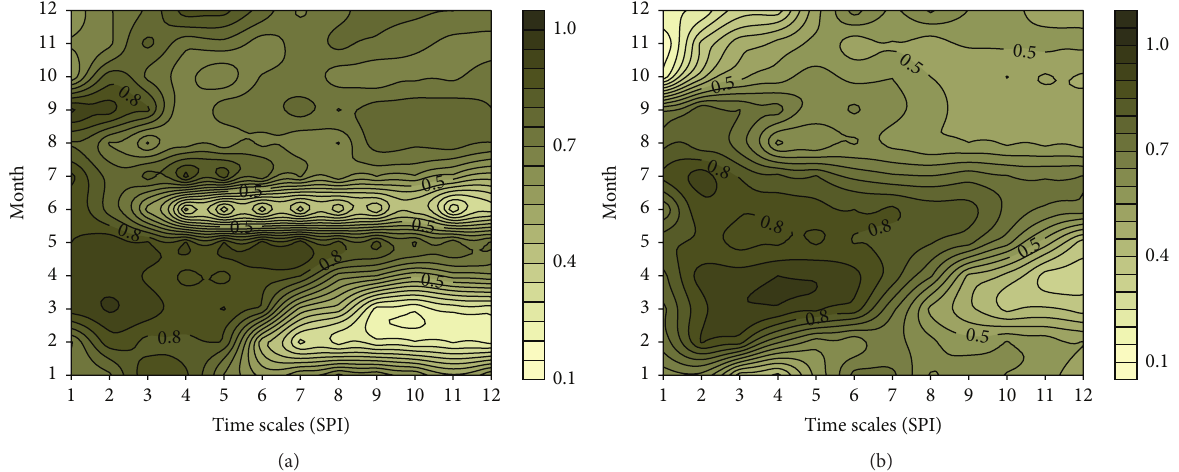
Figure 5: Monthly correlation coefficients between SSI-1 and SPI at different time scales (from SPI-1 to SPI-12) in Shilong hydrological station; (a) the period without reservoir effect (1960–1982); (b) the period with reservoir effect (1983–2010).